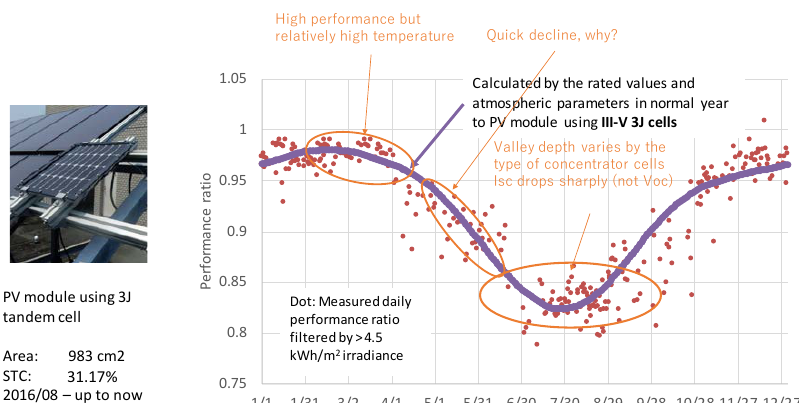
Figure 6. Comparison between the measured and modeled seasonal trends of the performance of the PV module using multi-junction solar cells [96]. Performance ratio can be calculated by the formula defined as PR = Yf/Yr, where PR is performance ratio, and Yf is the integrated energy yield of one day, and Yr is the nominal energy yield of one day calculated by the standard testing condition (STC) module efficiency and total insolation.